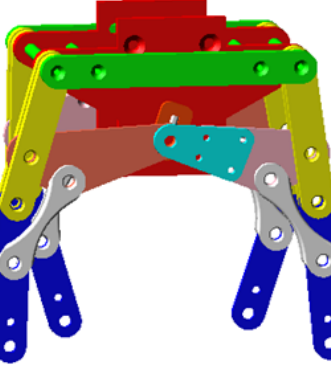
Figure 4. The F-point trajectories of different parameter groups.